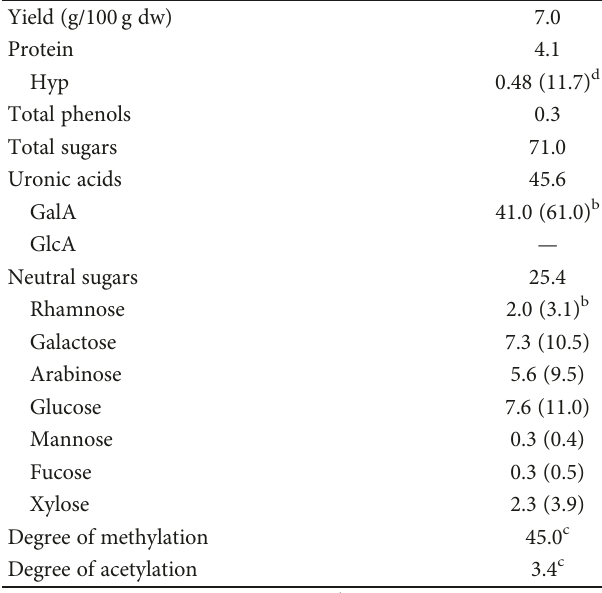
Table 1: Yield and chemical characterization of ammonium oxalate-extracted polysaccharide fraction from suspension culture of Fumaria o ffi cinalis L. (g/100 g dw) a